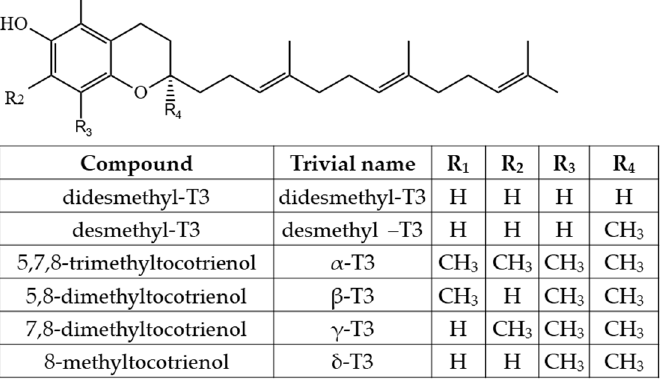
Figure 2. Chemical structures of tocotrienol-related compounds.